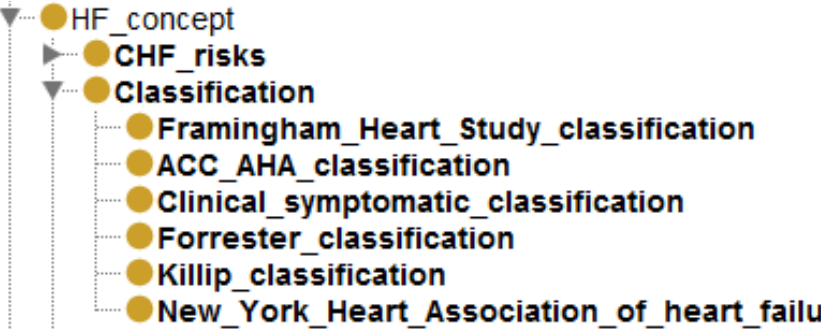
Figure 8. Framingham Heart Study (FHS) added to the HF classification